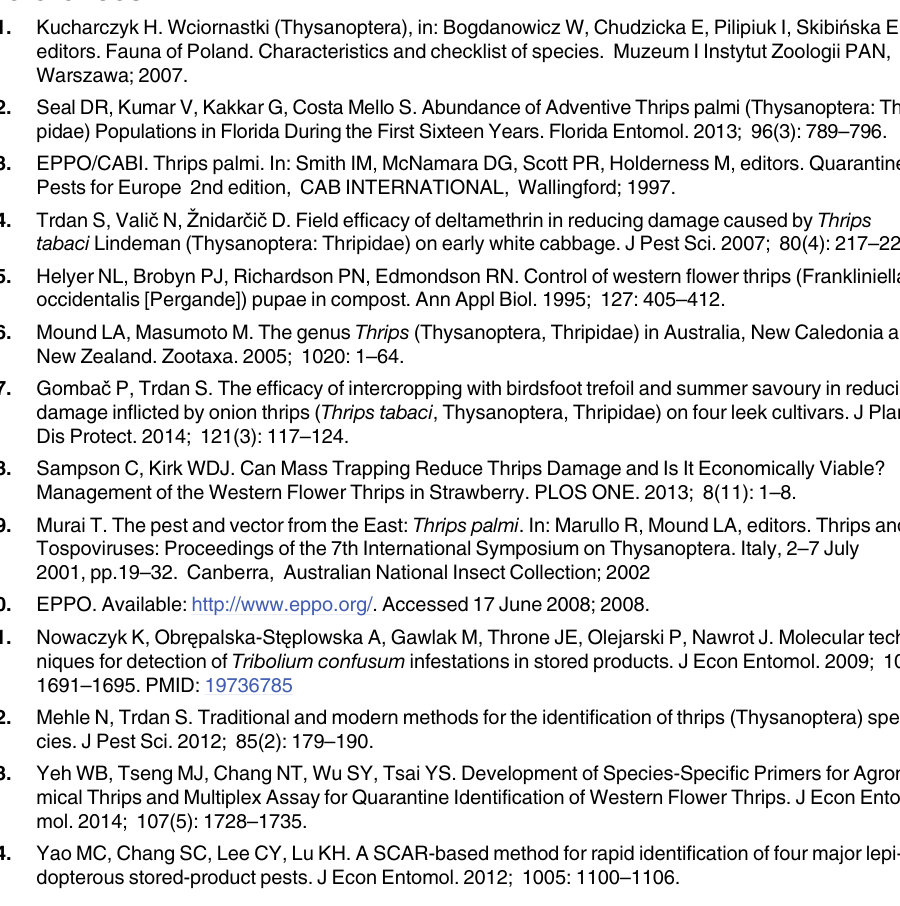
S3 Fig. Multiple sequence alignment of the rDNA region of Thrips palmi sequences in the GenBank database. Loop-mediated isothermal amplification (LAMP) primer sequences are indicated (black background). The alignment was generated using the GeneDoc software [23]. (TIF) S1 Table. Sequences from the GenBank database used for designing PCR and LAMP prim-